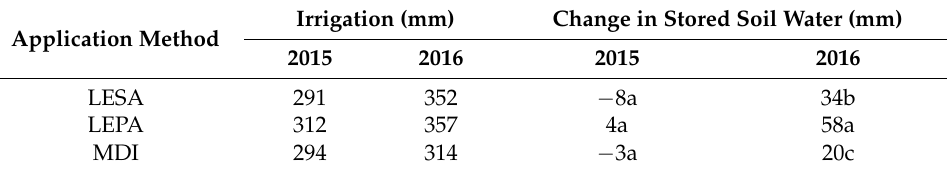
Table 3. Mean cumulative irrigation amounts and change in stored soil water (to the depth of 2.4 m) for each of the irrigation application treatments for 2015 and 2016. Mean values followed by the same letters are not significantly different for p <